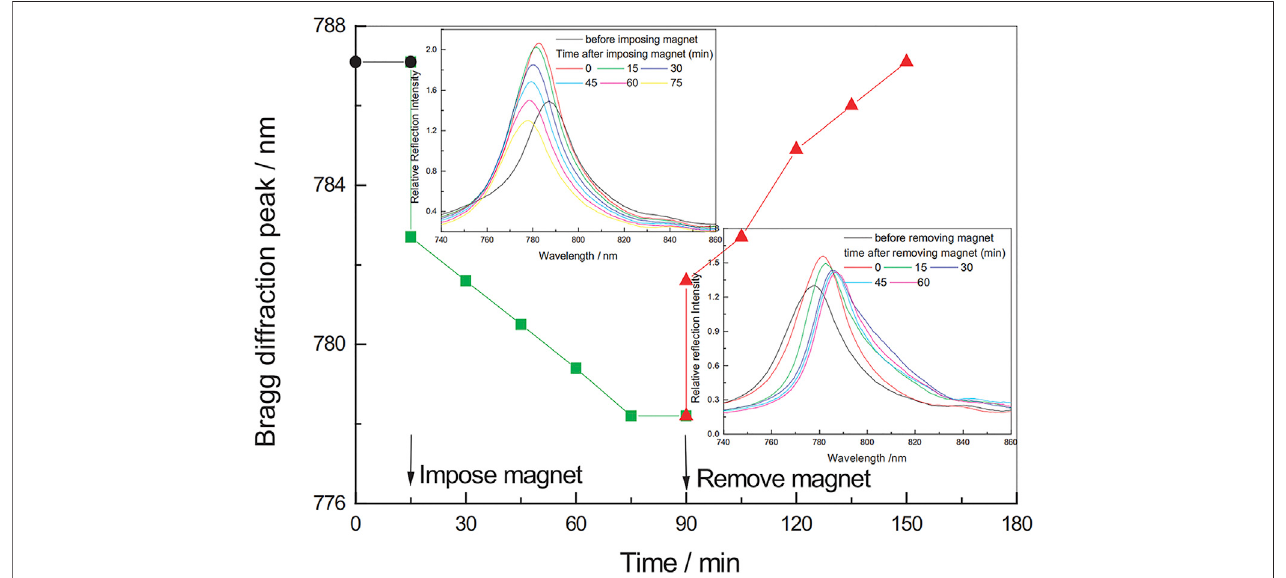
FIGURE 7 | Response of superparamagnetic PCCA fi lm to a 2.4 kOe MF with a 3.2 kOe/cm gradient. Reprinted with permission from Xu et al. (2001). Copyright © 2001 John Wiley and Sons.